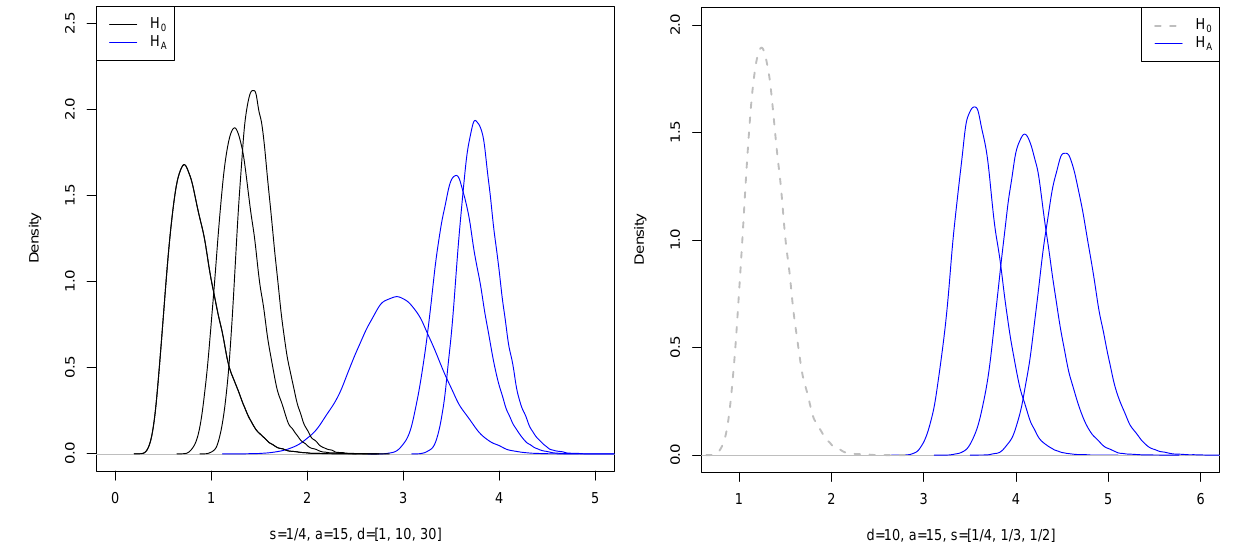
Figure 1. Density